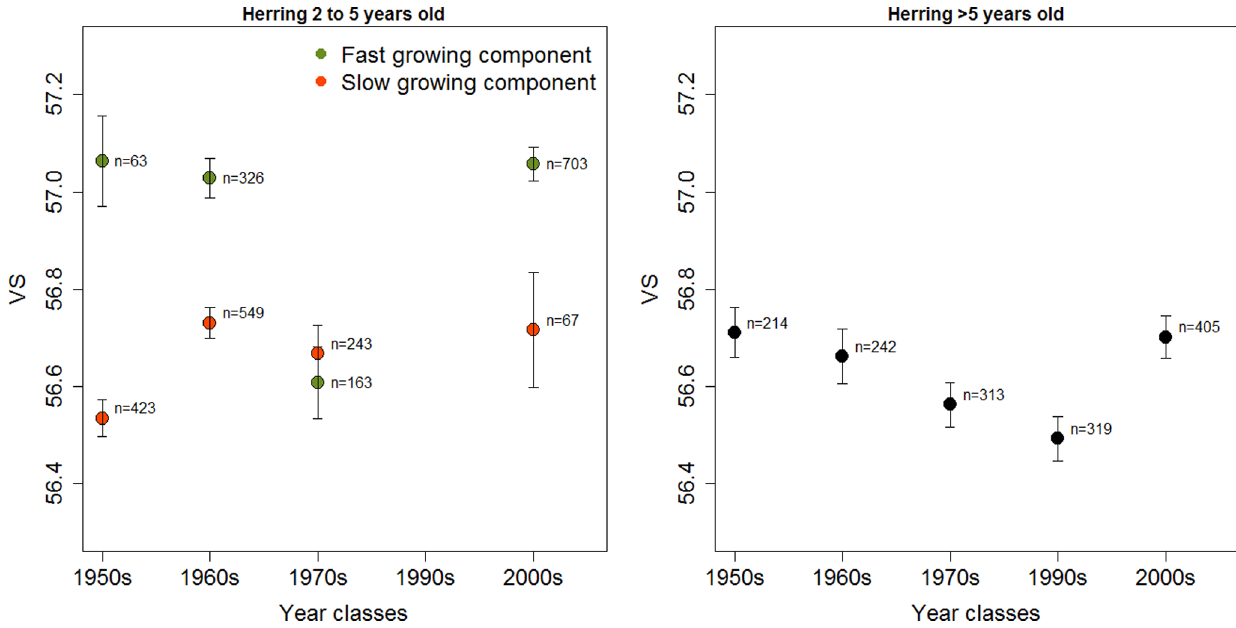
Figure 5. VS of young (2–5 years old) and older (6–11 years old) herring. Mean VS 6 SE of YCs of the decades 1950s to 2000s. Individuals with length-at-age closest to the 1950s slow-growing curve shown in red and the ones closest to the 2000s fast-growing curve shown in green. Sample size is given for the different components.